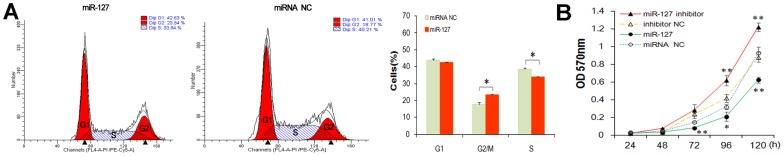
MiR-127 modulates rat liver cell growth.(A) Cell cycle of BRL-3A cells transfected with miR-127 mimics (miR-127) or miRNA negative control (miRNA NC) were analyzed by flow cytometry. (B) Proliferation of BRL-3A cells transfected with either miR-127 mimics (green), miR-127 inhibitor (red), miRNA NC (blue) or inhibitor NC (yellow) was examined at the indicated time by methylthiazol tetrazolium. Data from three independent experiments are shown as the means ± SD. (*P<0.05, **P<0.01).